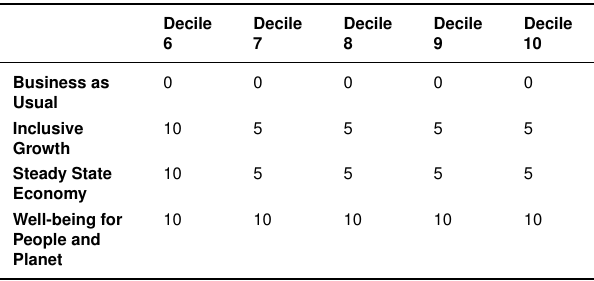
Table 4. Income tax rates (%) in different scenarios.